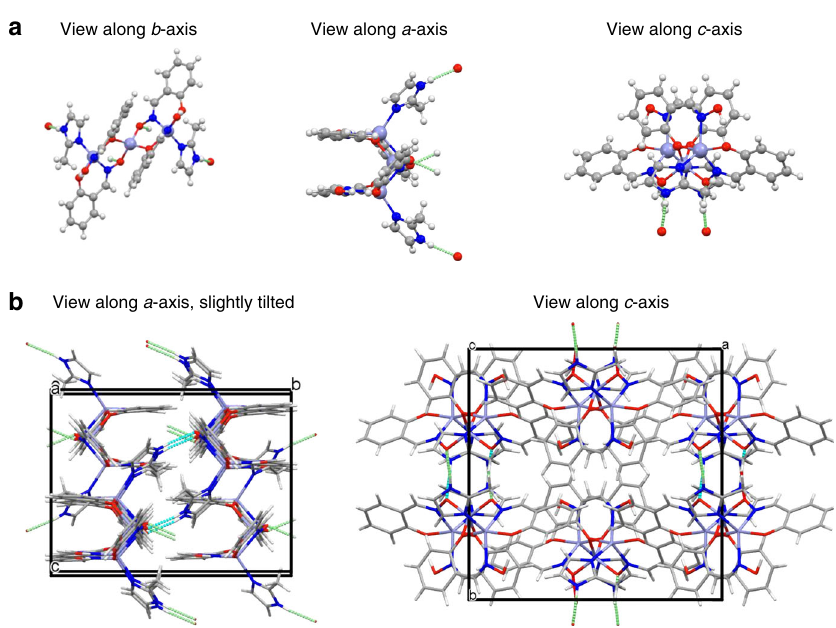
Fig. 1 Structures of ZIOS. a Structures of a trinuclear unit in ZIOS along each crystallographic direction, as obtained from synchrotron X-ray diffraction data; lavender, red, blue, gray, and white spheres represent Zn, O, N, C, and H atoms, respectively. b Different views of the three-dimensional supramolecular structure of one ZIOS unit cell with observed hydrogen-bonding interactions (green/cyan dotted lines); a wireframe model is used for simplicity and clarity. In the solid state, nanochannels created between stacked layers of trimers are separated by ~2.7 Å, close to the typical length of a solid-state hydrogen bond (2 – 3 Å). Further details of the ZIOS structure are shown in Supplementary Fig. 1 and Supplementary Tables 1 –